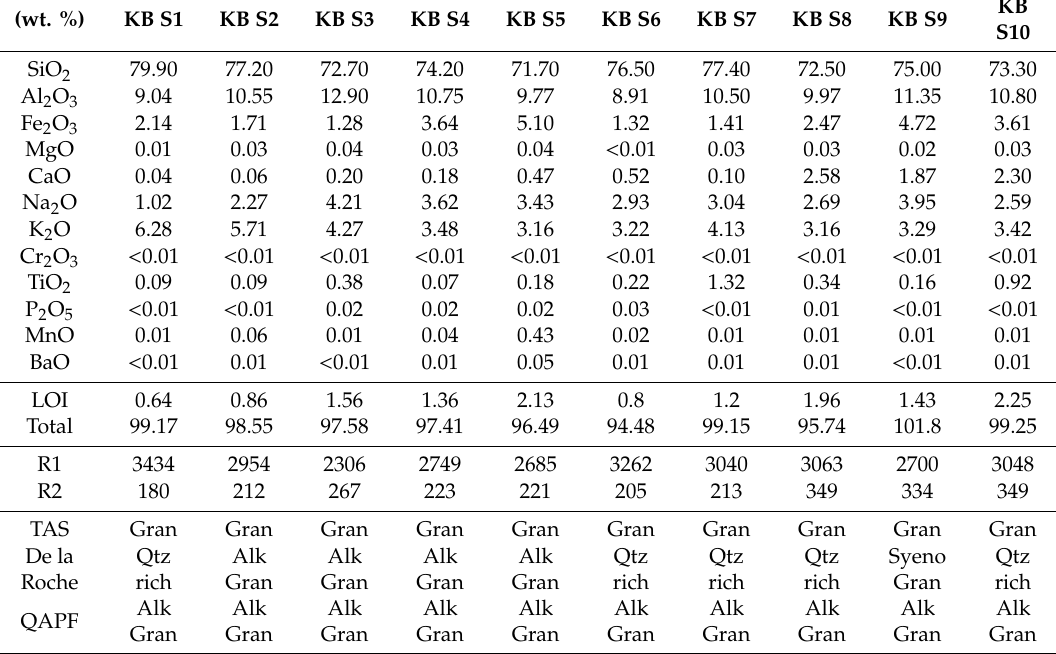
Table 2. Major element composition of KB S. TAS classification for plutonic rocks according to [22]. QAPF classification according to [20]. Parameters R1 and R2 and resulting classification calculated according to [21]. Abbreviations for TAS, de la Roche, and QAPF classifications as defined in Table 1. (wt.